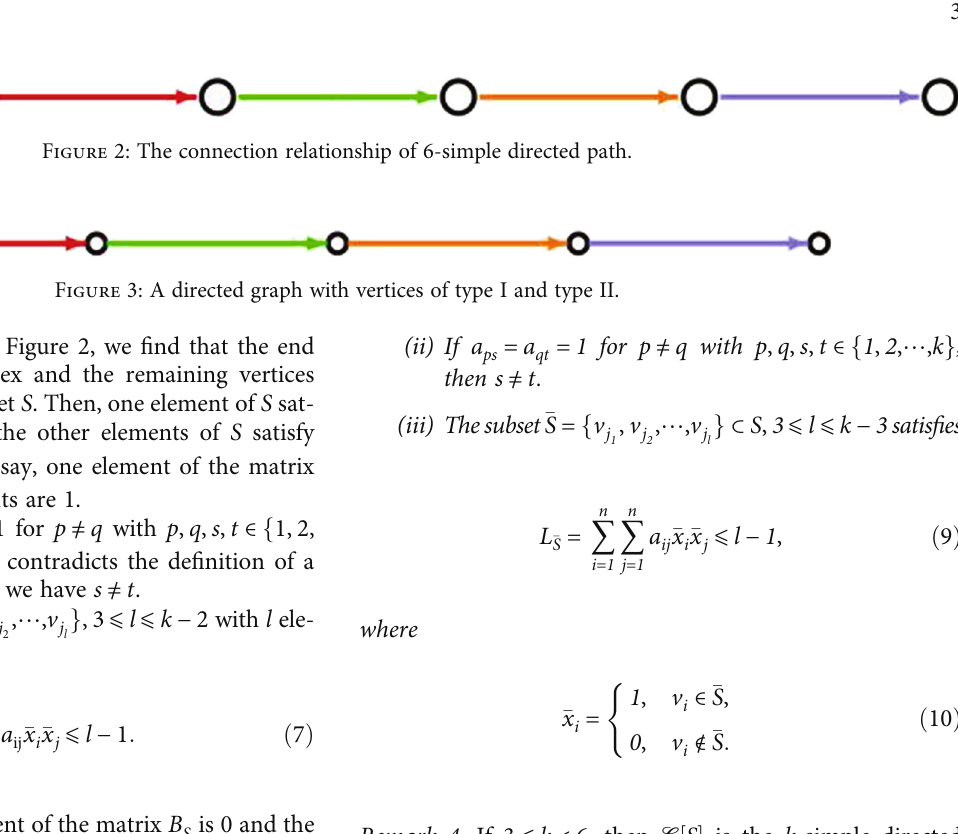
Figure 2: The connection relationship of 6-simple directed path.